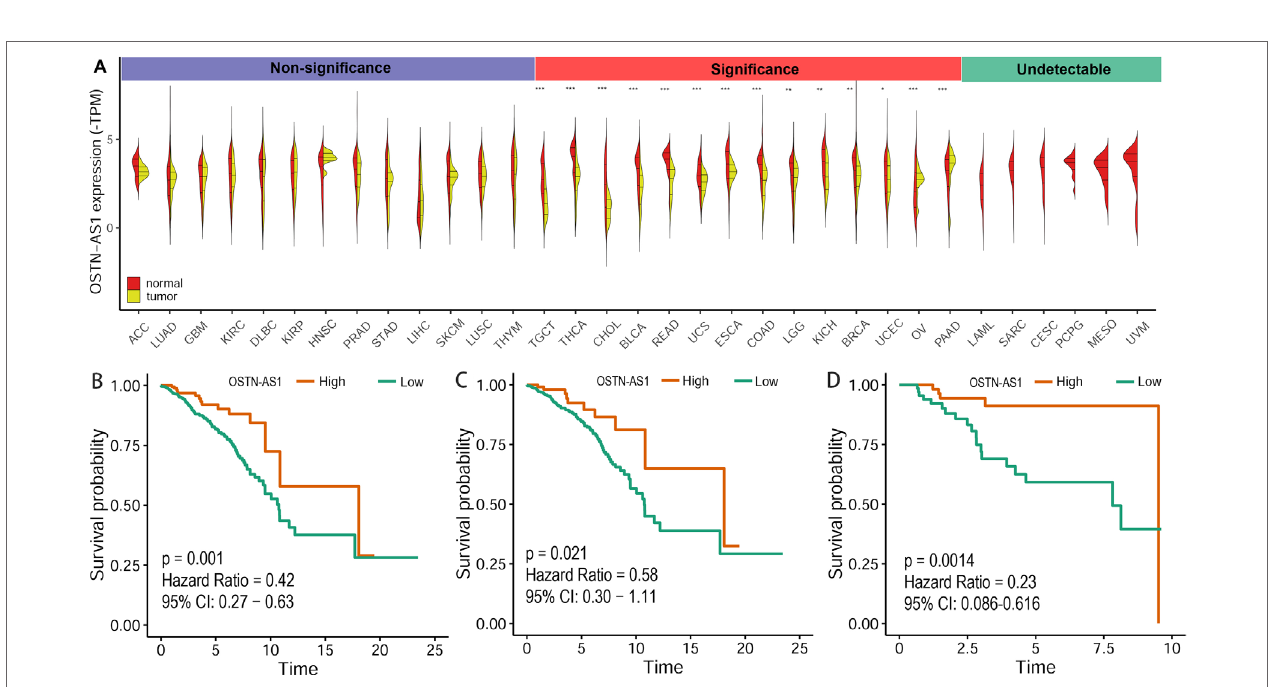
FIGURE 6 | Prediction of OSTN-AS1 as a tumor suppressor. (A) Violin plot constructed using transcripts per million reads (TPM) data downloaded from TCGA tumor database and GTEx normal tissue database to illustrate expression of OSTN-AS1 between multiple cancers and their corresponding normal tissues. (B-D) Overall survival analysis of OSTNAS1 in BRCA, nTNBC and TNBC. The abbreviation for each tumor was put in the Supplementary Table 3